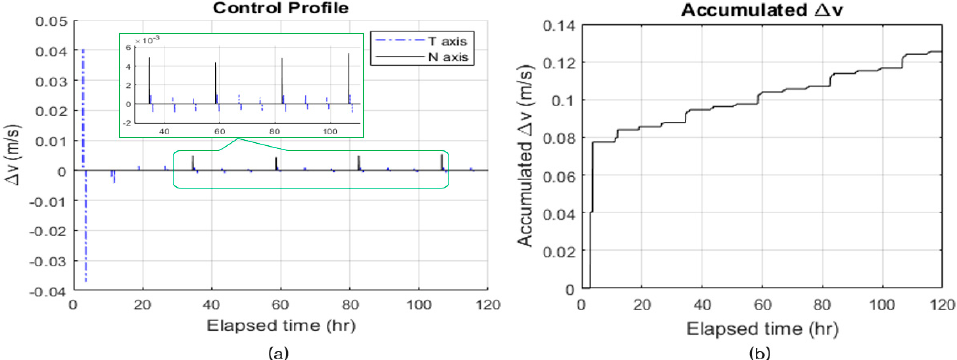
Figure 9. Simulation results of the relative orbit control algorithm. Thrust profile used for relative orbit control ( a ) and accumulated ∆ v ( b ) over elapsed time. The blue dotted line in ( a ) is the in-plane control thrust and the black solid line is the out-of-plane control thrust.